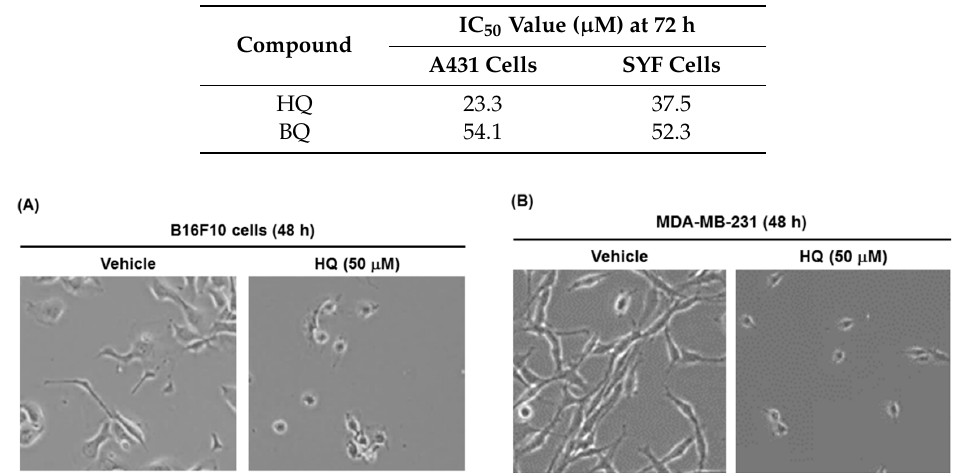
Table 1. Inhibitory activities (IC 50 values) of HQ and BQ.